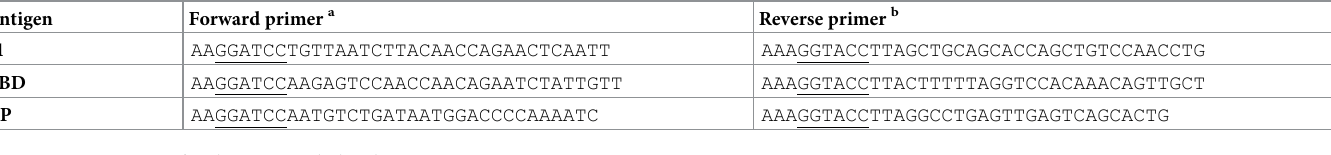
Table 1. Primer sequences for expression cloning SARS-CoV-2